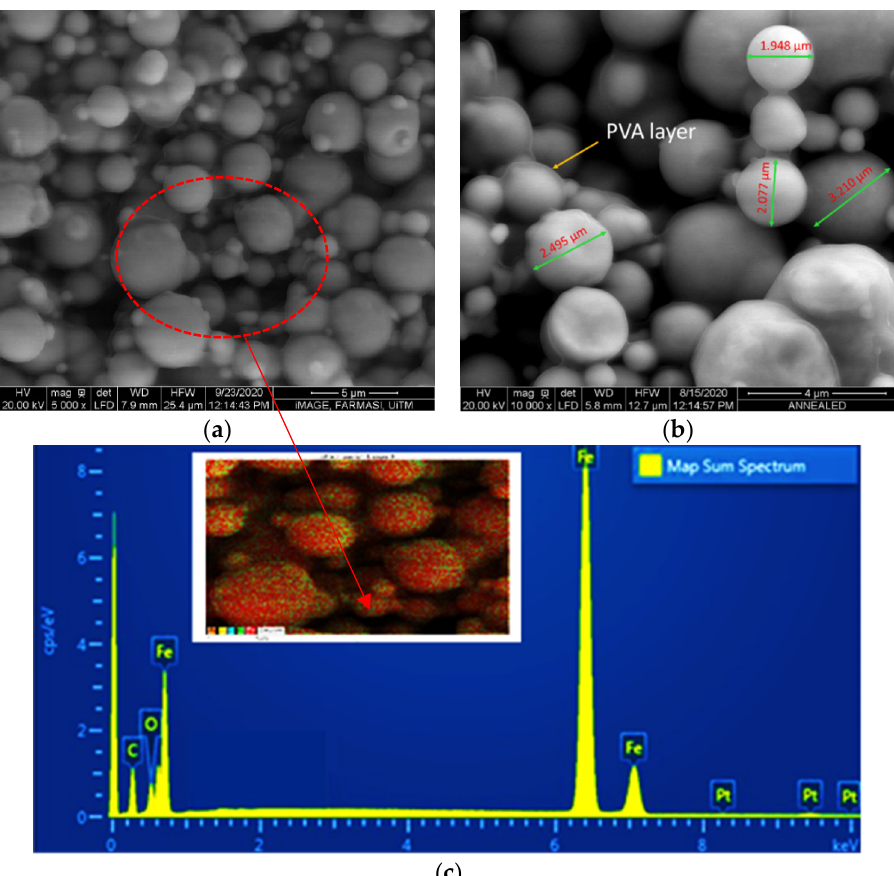
Figure 2. ESEM micrographs of the distribution of CIPs in the PVA-based MRP matrix, with magnifications of ( a ) ×5k and ( b ) ×10k, and ( c ) EDS mapping of the sample. Dot scanning analysis was conducted on the sample image as shown in the red dot circled in ( a ).